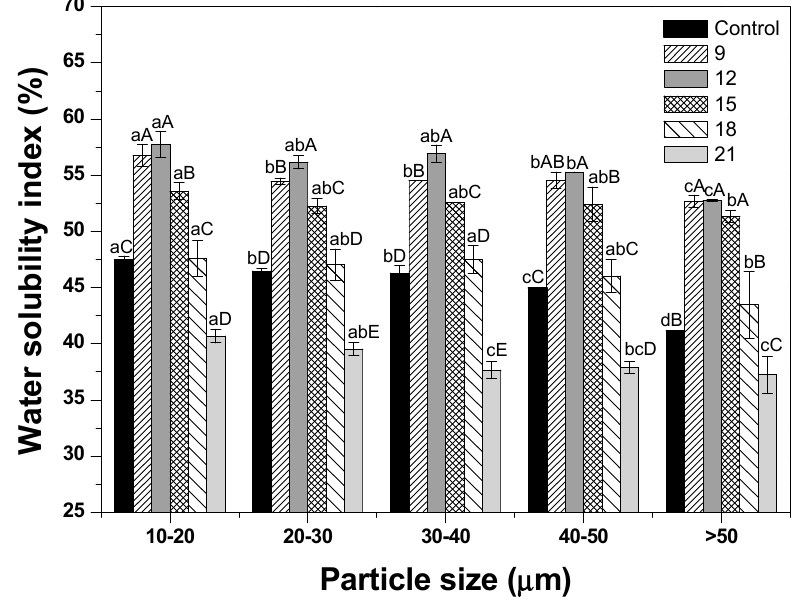
Figure 4. Water solubility index of dried ginseng powders with different particle sizes according to roasting time. After cryogenic milling of ginseng samples with different conditions, the samples were classified by their particle sizes. One treatment condition in each size range was then selected, and samples selected by particle size were then roasted and pulverized by cryogenic milling. a–d Means with different superscripts within the same time group are significantly different ( p < 0.05; Duncan’s test). A–E Means with different superscripts within the same size group are significantly different ( p < 0.05; Duncan’s test).